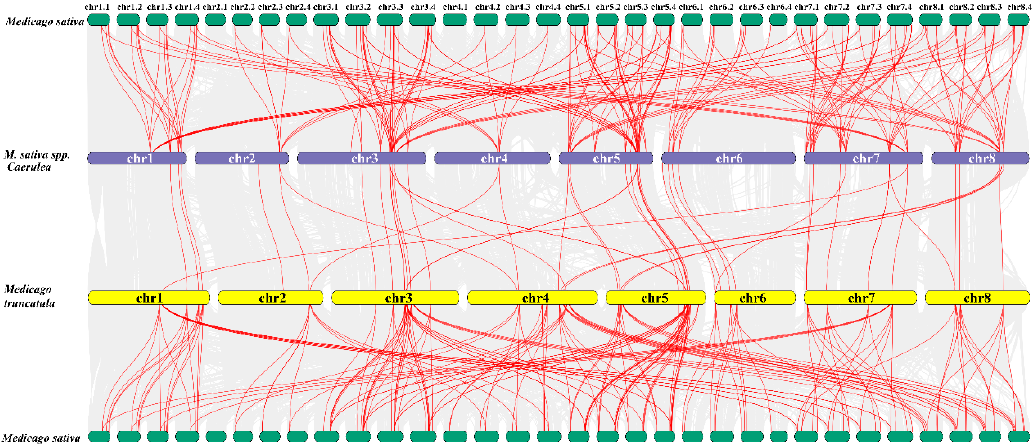
Figure 3. Gene synteny between Alfalfa , M. sativa spp. caerulea and M. truncatula . Red lines represent LBDs from the indicated